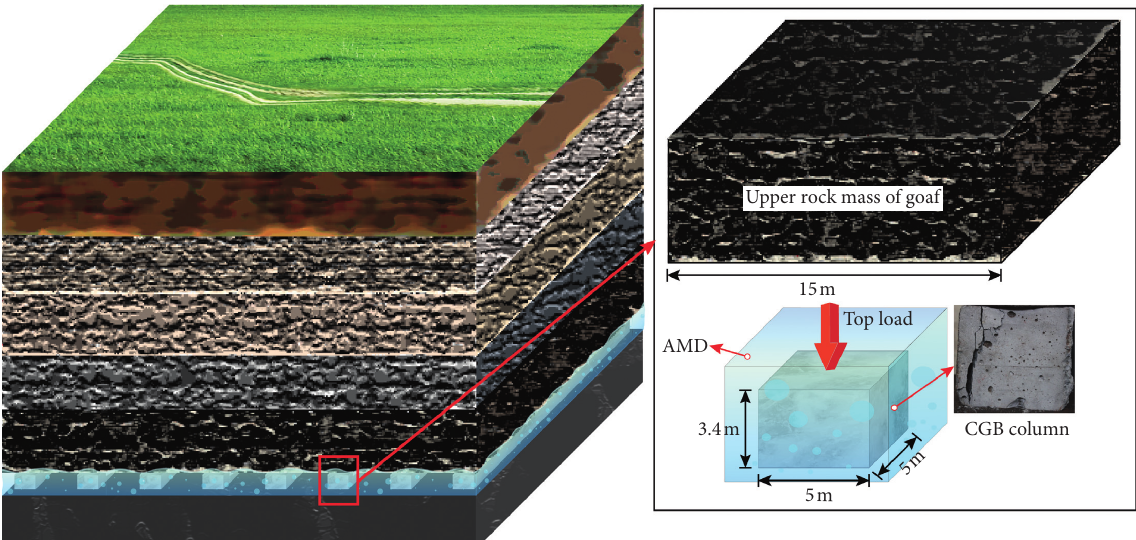
Figure 8: Mechanical model of the CGB column.